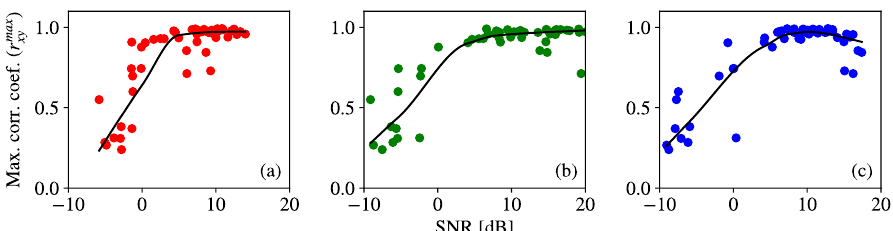
Figure 9. Values of r max xy from test image sequence of the fog-emulation experiment plotted against empirical SNR. The values are for frames taken with G V = 11 dB. The scatter plot in ( a ) corresponds to R channel, ( b ) to G channel, and ( c ) to B channel, and the curves in black are their corresponding LOESS regression for span value s =